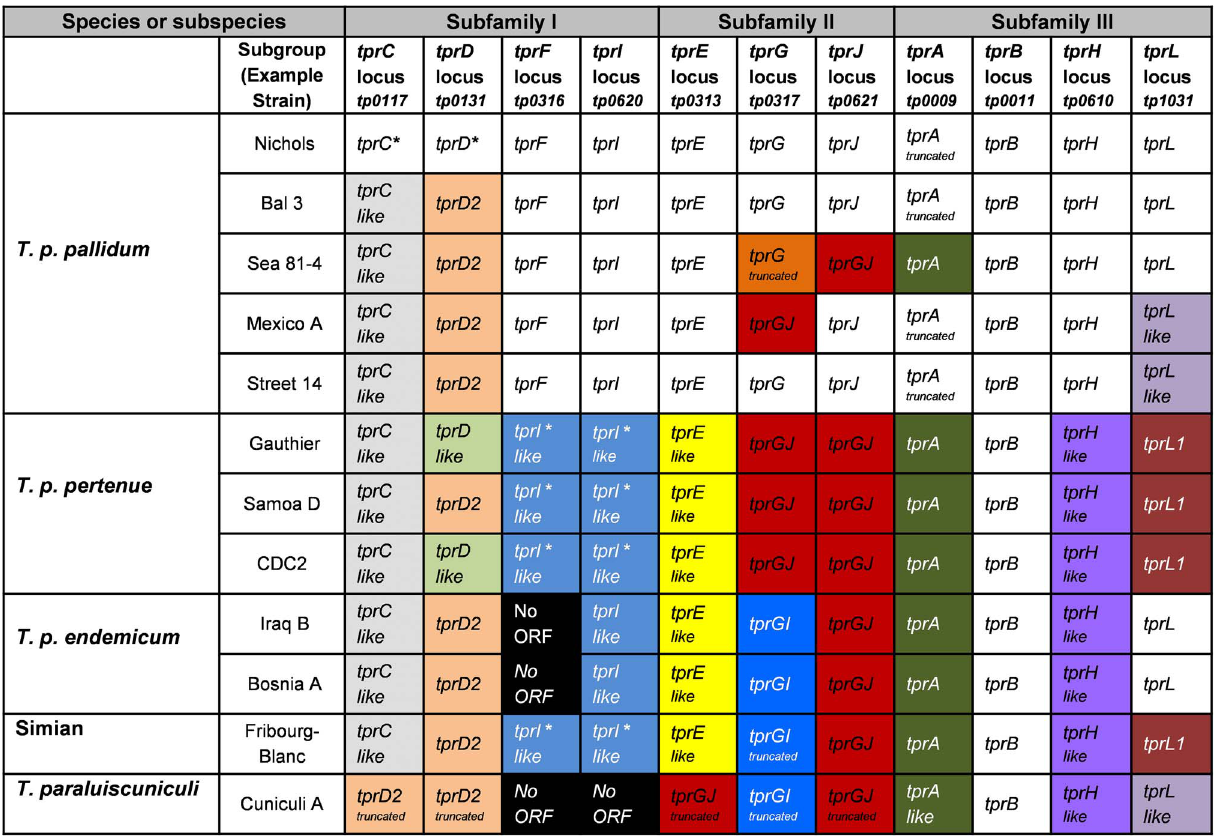
Figure 1. tpr alleles among treponemal species, subspecies and strains. tprD2 : A tprD allele which contains a 330-bp unique central region and three smaller heterogeneous regions at the 3 9 end. tprC -like and tprD -like: similar to tprC or tprD , respectively, with small sequence differences in discrete variable regions (DVRs). tprGJ : A chimera where the 3 9 end contains tprJ signatures. tprGI : A chimera where the 5 9 end is homologous to tprG , and the central and 3 9 regions are homologous to the corresponding regions of tprI . truncated: Predicted truncated proteins due to a frameshift. tprA - like, tprI -like and tprL -like contain small sequence differences. tprE -like and tprH -like contains small sequence differences that segregate syphilis from non-syphilis treponemes. tprL1 : A unique tprL allele in T. p. pertenue and Fribourg-Blanc strain. * indicates that tprC and tprD in the Nichols strain and that tprI -like sequences in the tprF and tprI loci are also identical in the pertenue subspecies and the Fribourg-Blanc treponeme. locus appended as Figure S1. For practical and comparison